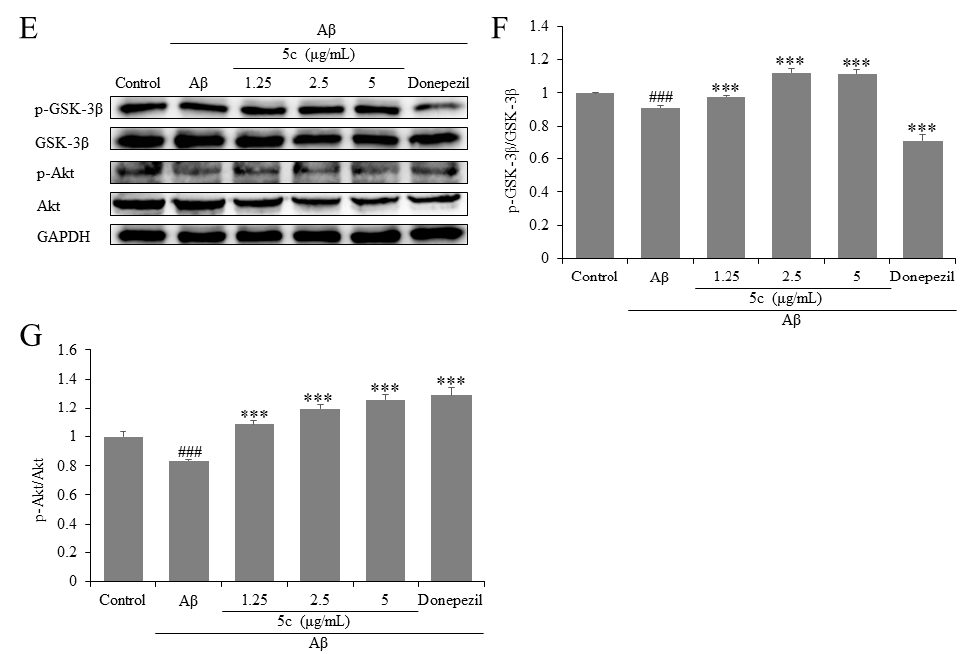
Figure 3. Phosphorylation effects of compound 5c on tau, glycogen synthase kinase (GSK-3 β ) and Akt in A β 25-35 -induced PC12 cells. ( A ) The protein levels of tau were detected by Western blotting. Quantifications of Thr181-p-tau ( B ), Thr205-p-tau ( C ), and Ser396-p-tau ( D ) expression are presented in bar graphs, respectively. ( E ) The protein levels of GSK-3 β and Akt were detected by Western blotting. Quantifications of GSK-3 β ( F ) and Akt ( G ) expression are presented in bar graphs, respectively. ### p < 0.001 vs. control group; ** p < 0.01; *** p < 0.001 vs. model group.